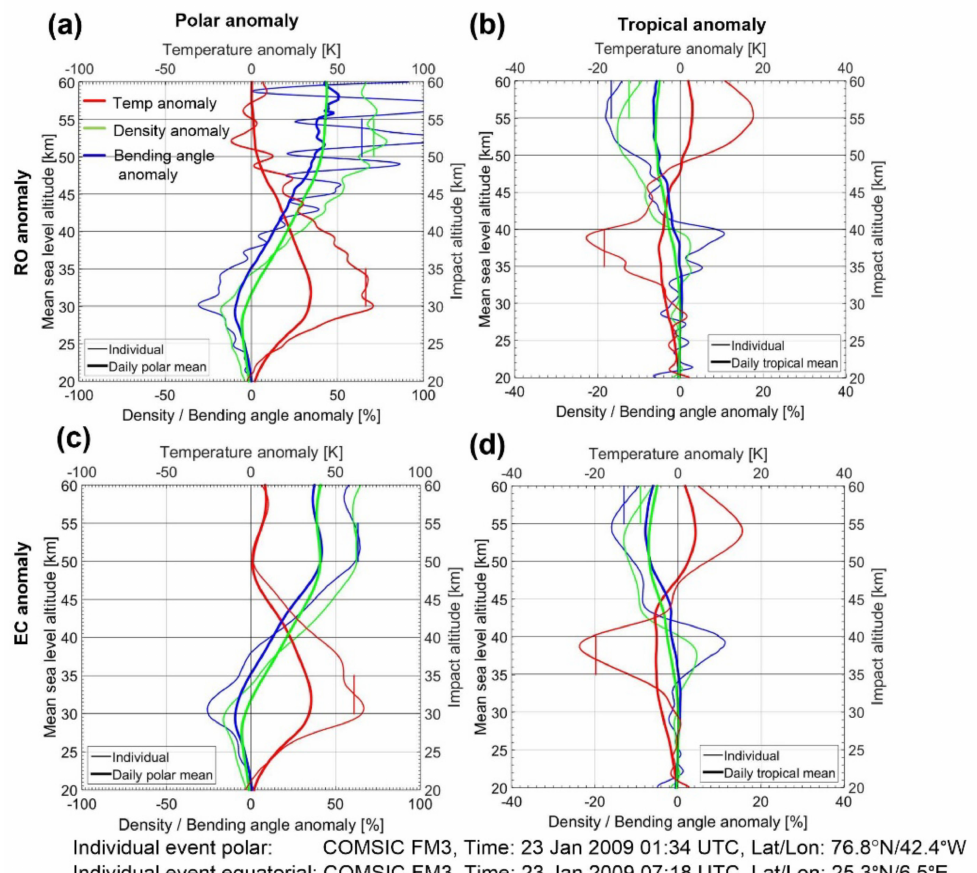
Figure 2. Panel ( a ): RO temperature, density, and bending angle anomaly profiles of an individual RO event located in the polar region (thin lines) and of polar mean results (thick lines). Panel ( b ): RO anomaly profiles of an individual RO event located in the tropical region (thin lines) and of tropical mean results (thick lines). Vertical, thick lines represent vertical mean anomalies of individual anomaly profiles within corresponding altitude layers, and these vertical mean anomalies are used in following figures for illustrating spatial and temporal variations of anomalies. Panels ( c , d ) are the same as panels ( a , d ), respectively, but for ECMWF results; the locations of these two individual events are denoted in Figure